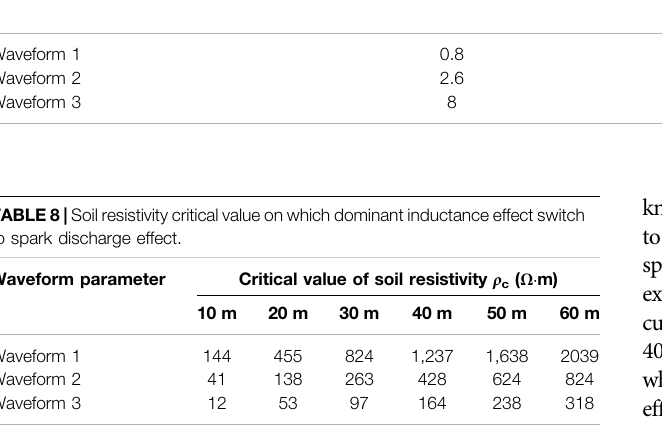
TABLE 7 | Computation parameters of lightning current impulse waveform. Waveform parameter